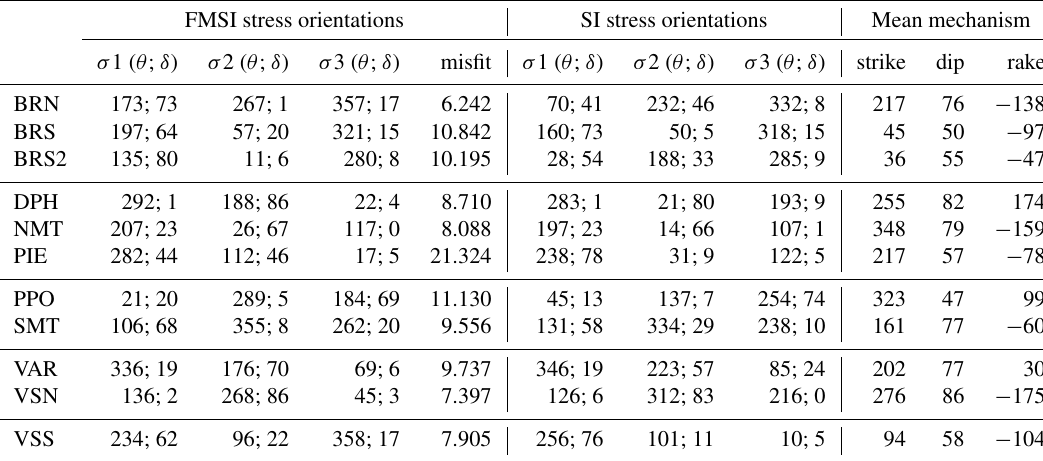
Figure 5. Comparison of stress orientations resulting from FMSI (a) and SI (b) inversions of focal mechanisms within each subarea. The most compressional ( σ 1, in red) and least compressional ( σ 3 in blue) stresses are plotted given their plunge (i.e. arrows length depending on the plunge: the scale arrows in the bottom-left corner represent 0 ◦ plunging stress axes (horizontal stresses), while 90 ◦ plunging stress axes will not be seen on the map). The mean focal mechanism retrieved from SI inversion, corresponding to each partial stress tensor, is plotted for each subarea in (b) . Table 2. Stress (FMSI and SI) results for each of the 11 subareas. Stress orientations display the azimuth ( θ , in degrees from north) and the dip ( δ , degrees) of the most compressional stress ( σ 1), intermediate stress ( σ 2), and least compressional stress ( σ 3) for the two methods. FMSI also yields a misfit value (dimensionless) for the deviatoric stress tensor constituted by the three principal stresses. SI yields the focal mechanism corresponding to the inverted deviatoric stress